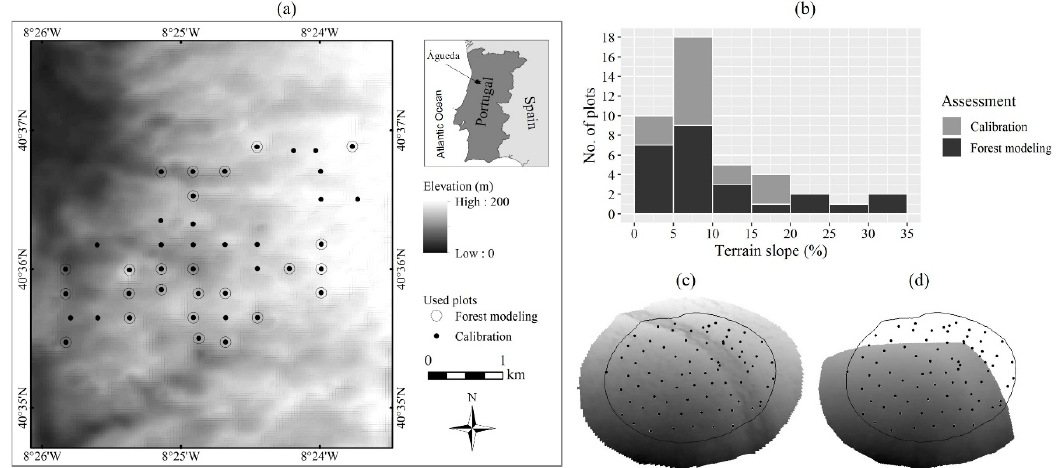
Figure 1. ( a ) Map of plots distributed over the area. ( b ) Histogram of mean terrain slope within plots used on the filtering calibration assessment (41 plots) and forest modeling assessments (25 plots). ( c ) Exemplification of a digital terrain model (DTM) with their respective control points within a plot. ( d ) A showcase example of an eroded DTM for the plot ( c ).